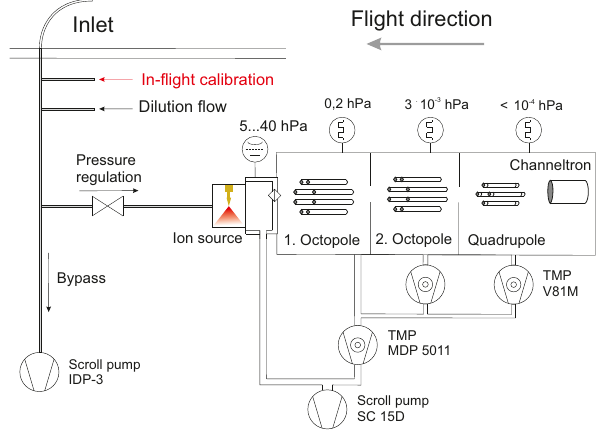
Figure 2. Schematic of the flight configuration of AIMS. Ambi- ent air enters via a backward faced inlet and passes through a pres- sure regulation valve before entering the ion source. The detailed setup of the ion source for the two measurement modes is depicted in Fig. 5. The ion beam is then focused by two adjacent octopoles and finally separated by mass-to-charge ratio in the quadrupole. Ad- ditionally, connections for an optional dilution of ambient air and background measurements and for addition of trace gases for in- flight calibration (detail in Fig. 3) are mounted right beneath the